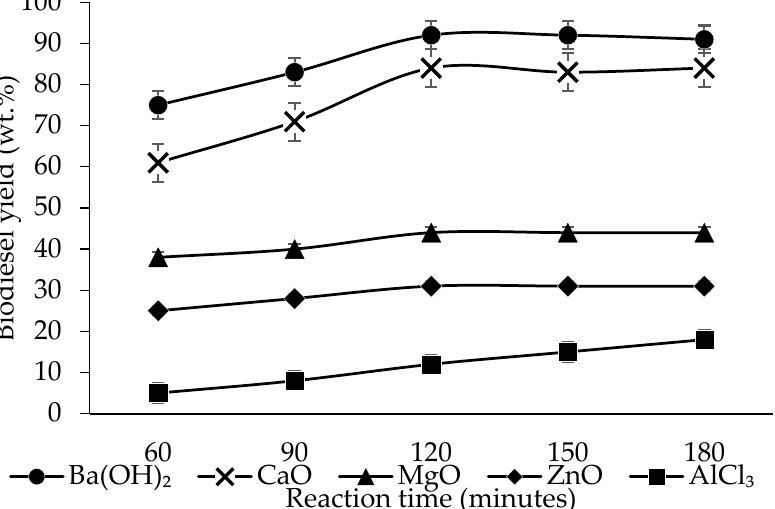
Figure 7. Effect of reaction time on biodiesel yield (catalyst loading 5 wt.%; methanol-to-oil molar ratio of 12:1, speed 600 rpm).